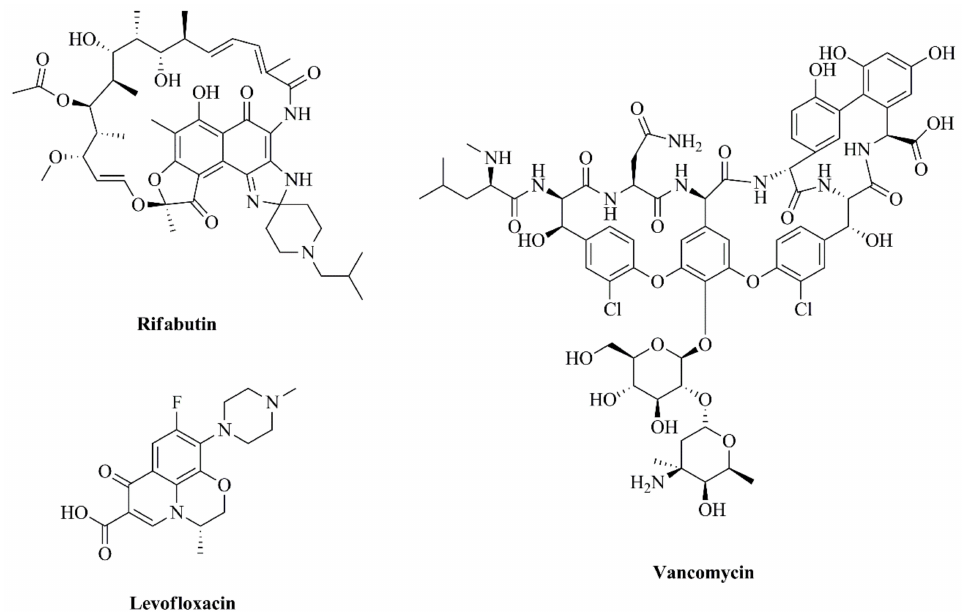
Figure 1. Chemical structures of antibiotics selected in the current study: rifabutin (RFB), levofloxacin (LEV) and vancomycin (VCM). Chemical structures were obtained through a chemistry drawing software, ChemDraw ® ultra